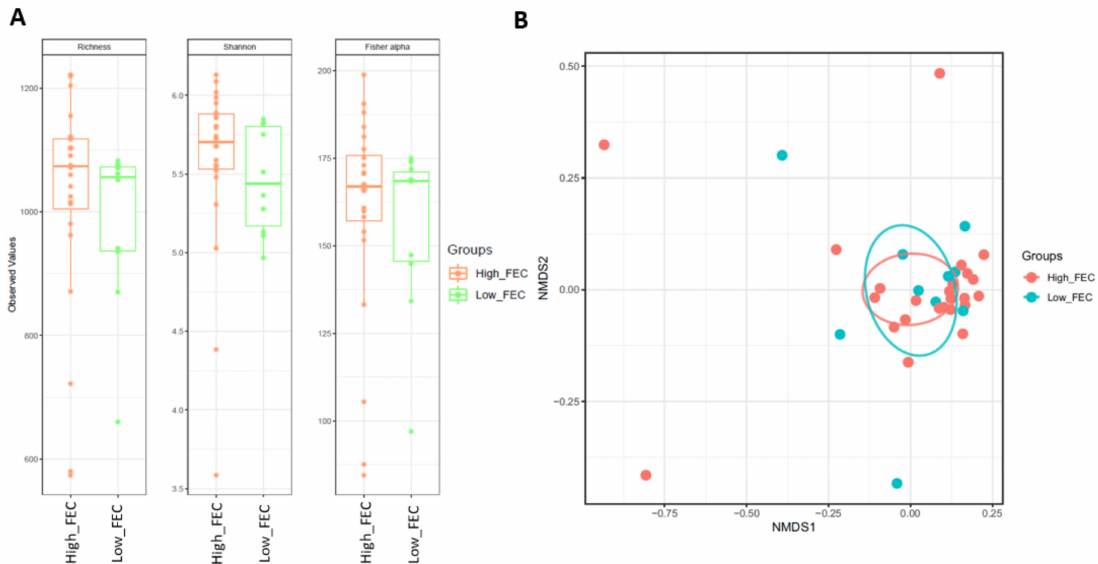
Figure 3. Alpha ( A ) and beta ( B ) (Bray-Curtis distance is shown) diversity indices for horses with low (<10 e.p.g) and high (>100 e.p.g) strongyle FECs. Alpha diversity was not significantly different between groups, pair-wise ANOVA ( p > 0.05). The beta diversity between groups was not significant (permutational multivariate analysis of variance, p > 0.05) Key: High_FEC = high strongyles (>100 e.p.g) n = 24, Low_FEC = low strongyles (<10 e.p.g) n = 10, FEC = faecal egg count, e.p.g = eggs per gram, NMDS = non-metric multidimensional